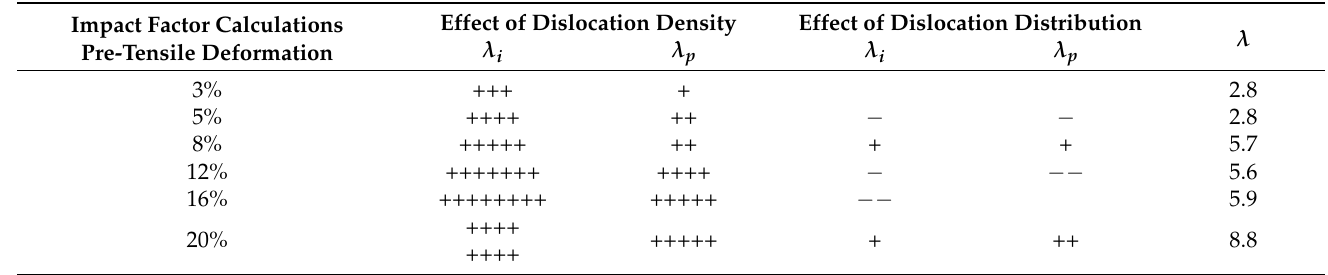
Table 1. Calculated impact factors of pre-tensile deformations on fatigue life of annealed 7005 alu- minum alloy plate according to Equation